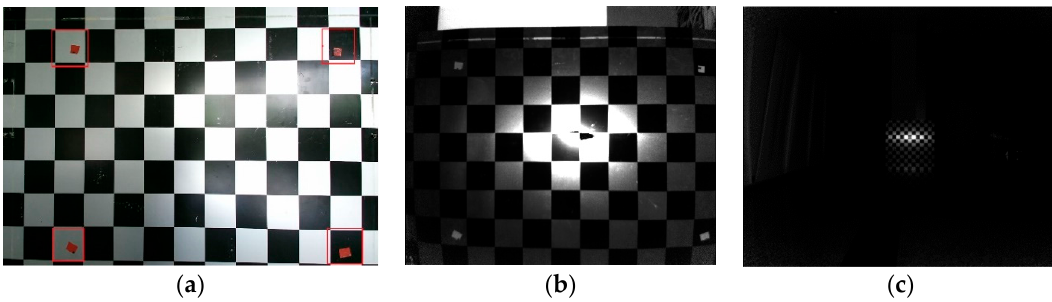
Figure 6. Image of checkerboard and infrared image: ( a ) checkerboard; ( b ) infrared image captured at a distance of 0.5 m; ( c ) infrared image captured at a distance of 4.5 m.